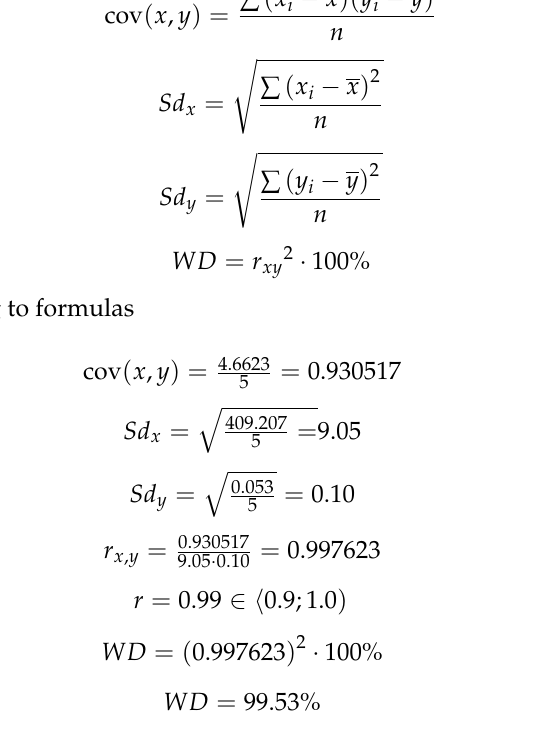
Table 3. Calculation data from the correlation of the mud cake removal efficiency to the adhesion of the cement sheath in contact with the rock